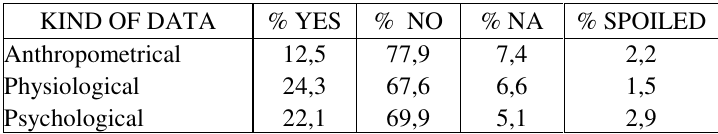
THE KIND OF DATA USED FOR ERGONOMIC ANALYSIS KIND OF DATA % YES % NO % NA % SPOILED Anthropometrical 12,5 77,9 7,4 2,2 Physiological 24,3 67,6 Psychological